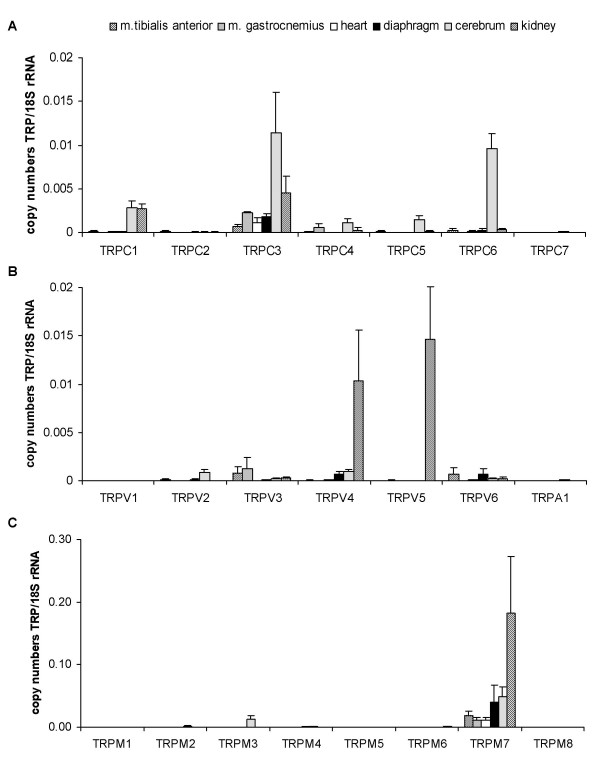
Quantification of TRP ion channel mRNA levels in murine tissues using Real-time RT-PCR. Expression of TRPC1-7 (A), TRPV1-6 and TRPA1 (B) as well as TRPM1-8 (C) mRNA was analyzed in murine tissues using Real-time RT-PCR. Samples were from adult (100 d) C57Bl/10SC mice. The mRNA levels of TRP ion channels are given in relation to 18S rRNA. Means ± S.E.M. are given in all cases for n = 3–10 samples.